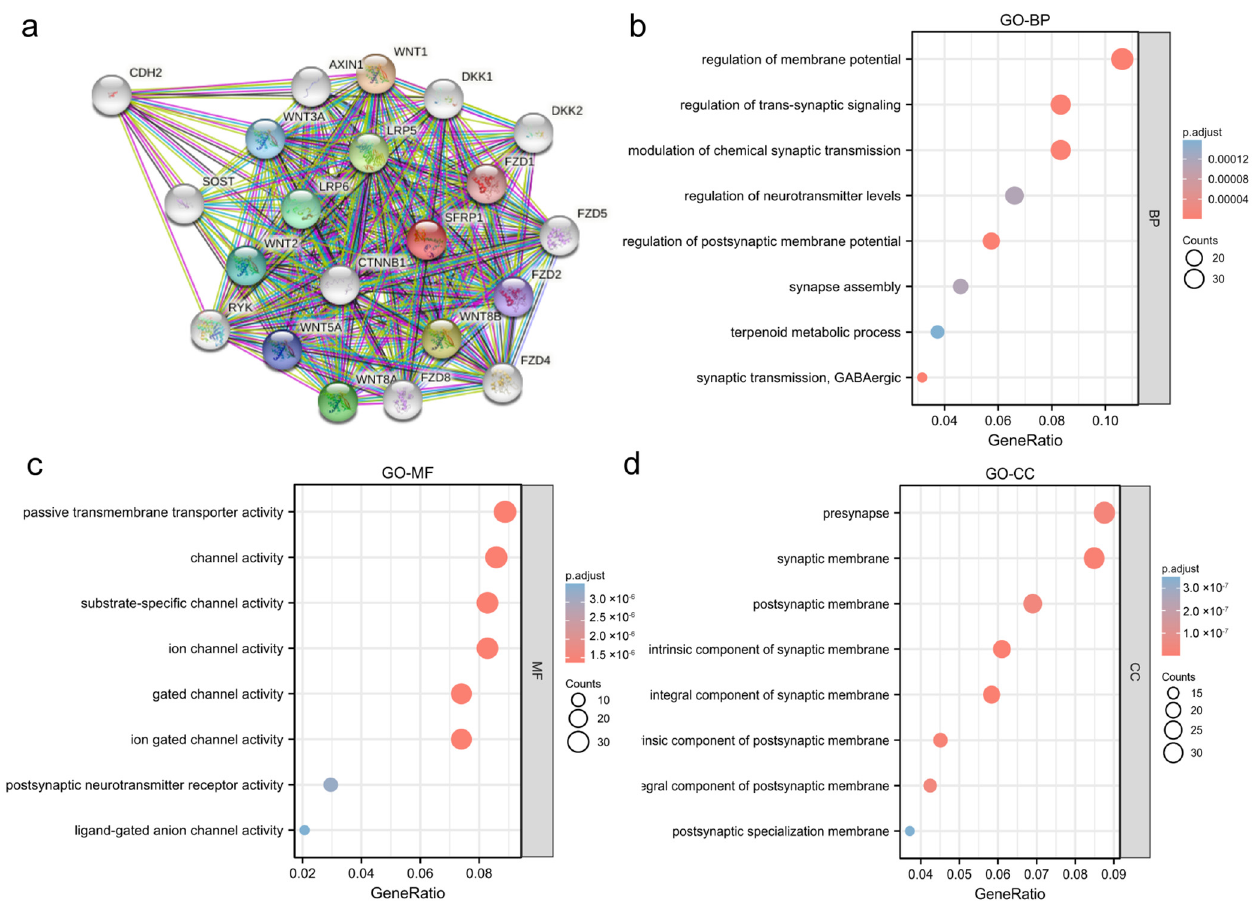
Figure 6. Differentially expressed genes (DEGs) between cases with high- and low-SFRP1-expres- sion groups. ( a ) Volcano plot of differentially expressed genes; ( b ) heatmap of the top 10 significant differentially expressed genes. * p < 0.05, ** p < 0.01, and *** p < 0.001.